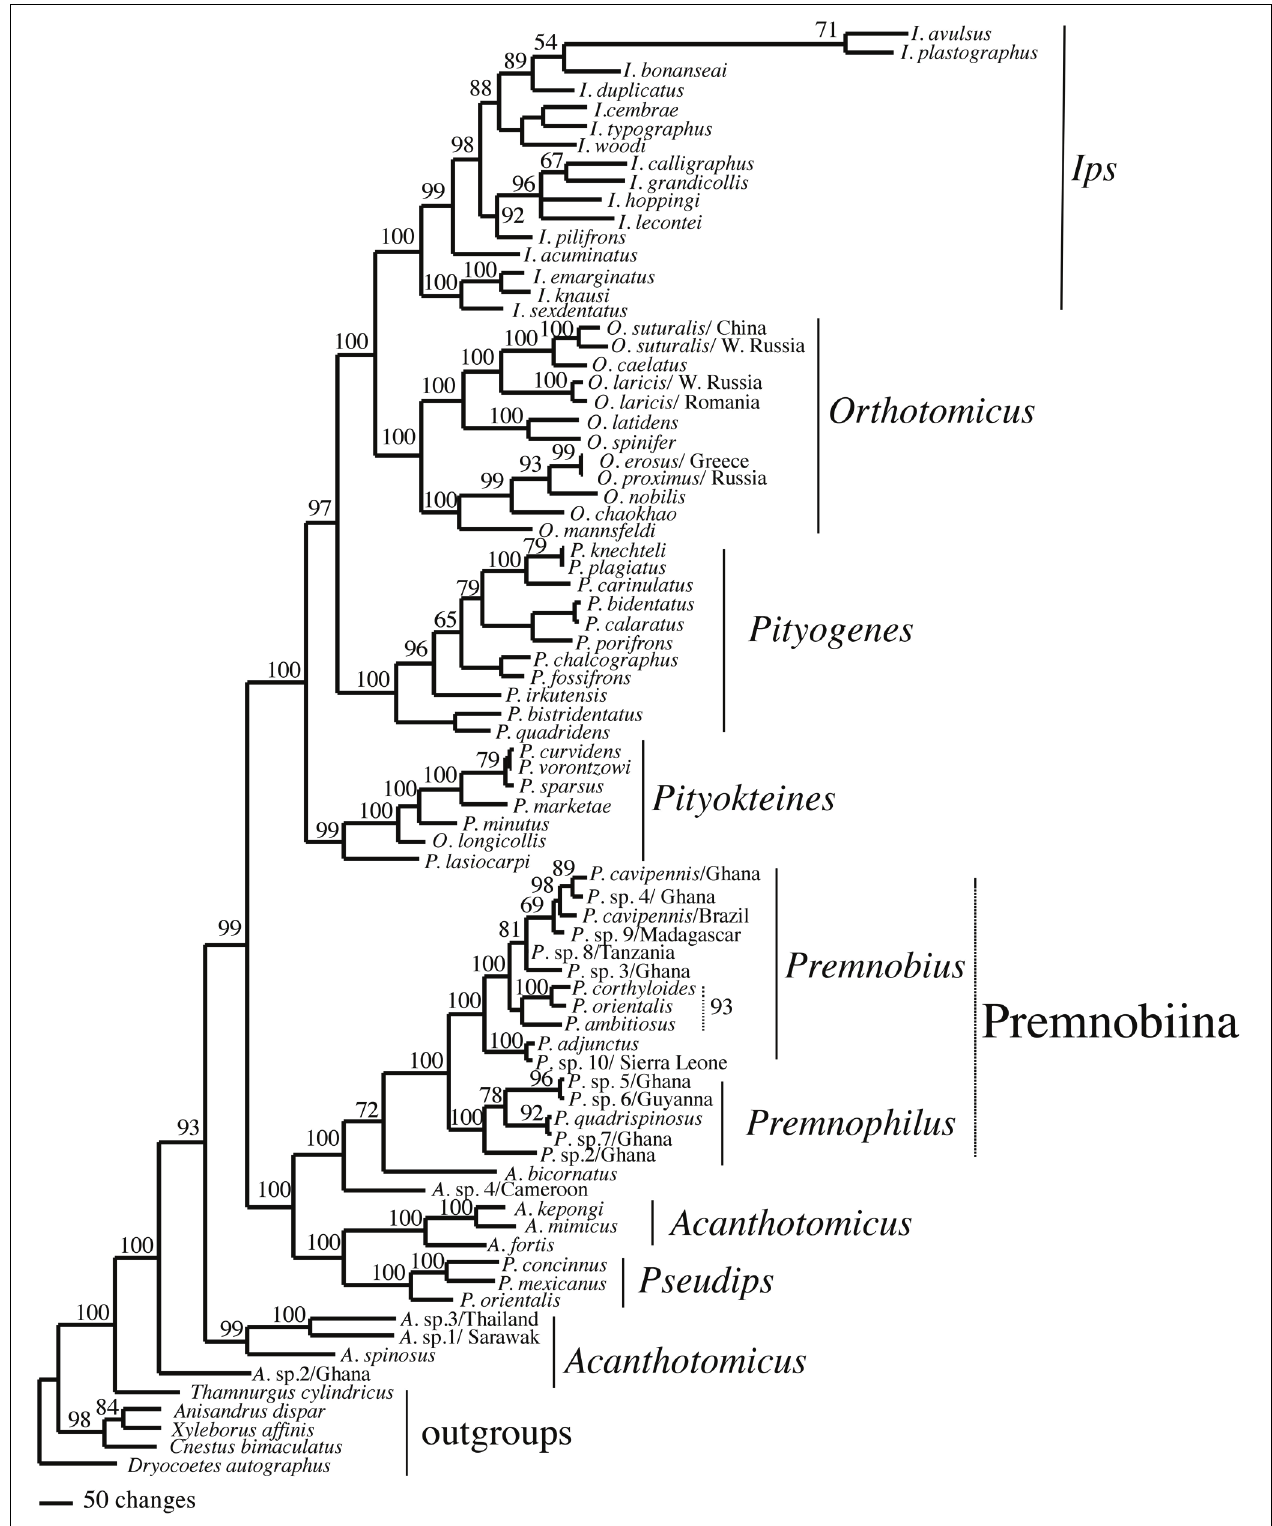
FIGURE 3 | Majority rule consensus of 75,000 trees found in a Bayesian analysis of Ipini and outgroup species. Numbers are posterior probabilities.